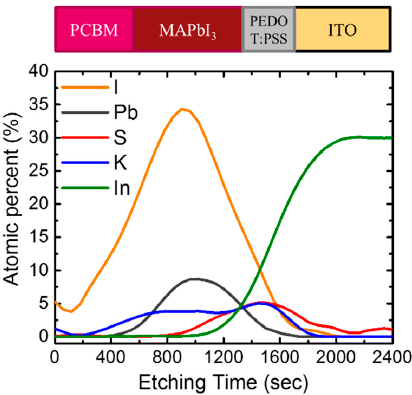
Figure 8. Auger electron spectroscopy (AES) depth profile of MAPbI 3 prepared on PEDOT:PSS coated ITO (indium tin oxide) glass.